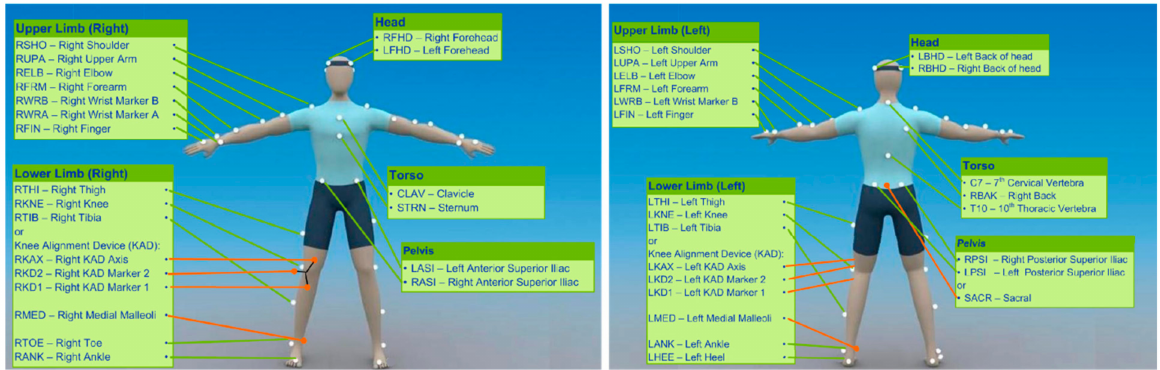
Figure 5. Markers’ layout according to the PlugInGait full body